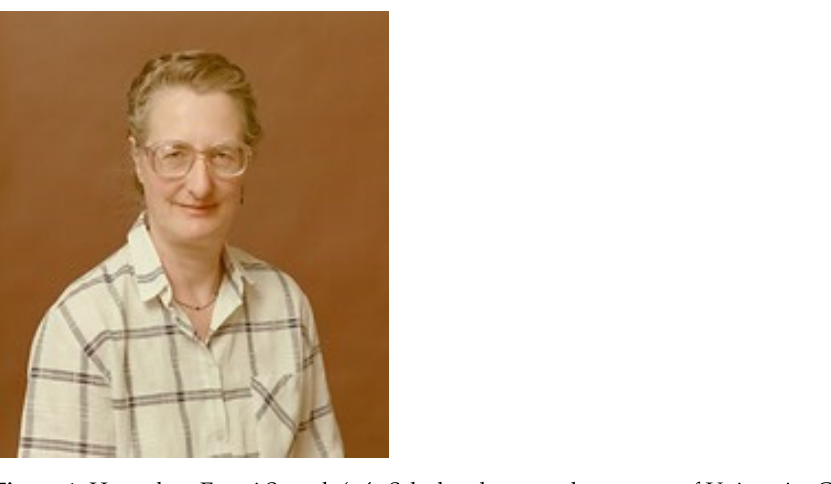
Figure 1. Hannelore Emmi Saraph (née Schulz; photograph courtesy of University College London Educational Media).